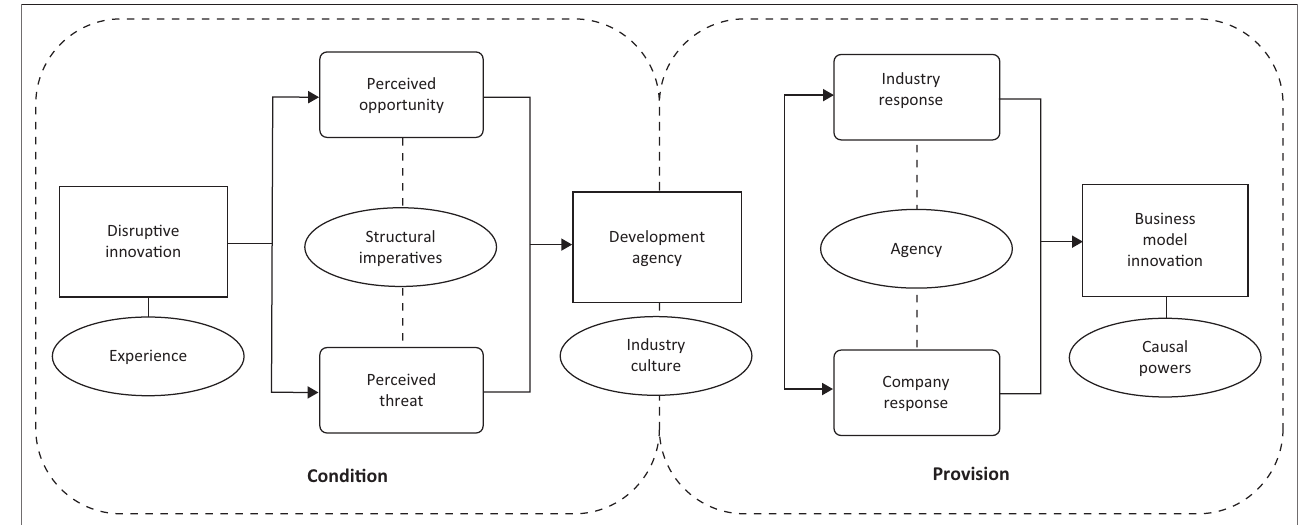
FIGURE 3: The Disruptive Innovation State Response